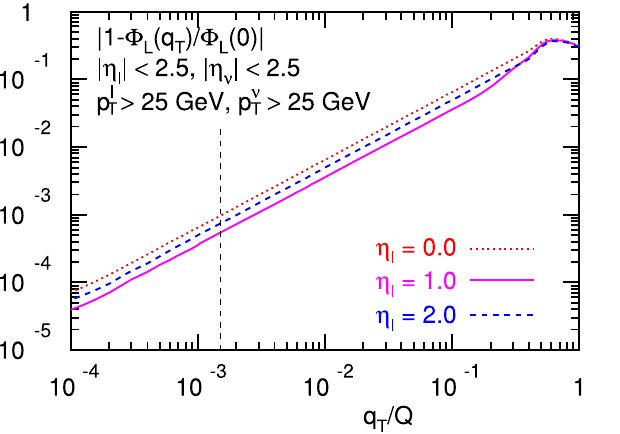
Fig. 15 The difference between the Born and real emission phase spaces (cid:13) L ( 0 ) − (cid:13) L ( q T ) of the decay leptons relative to the Born one at fiducial cuts applied to ATLAS data set [6] for Z /γ ∗ -boson production ( Q = M Z ) for different values of the gauge boson pseudo-rapidity η ll . ≥ 20 GeVarerequired.Left:Cutsselecting Fortheleptonmomenta p l T